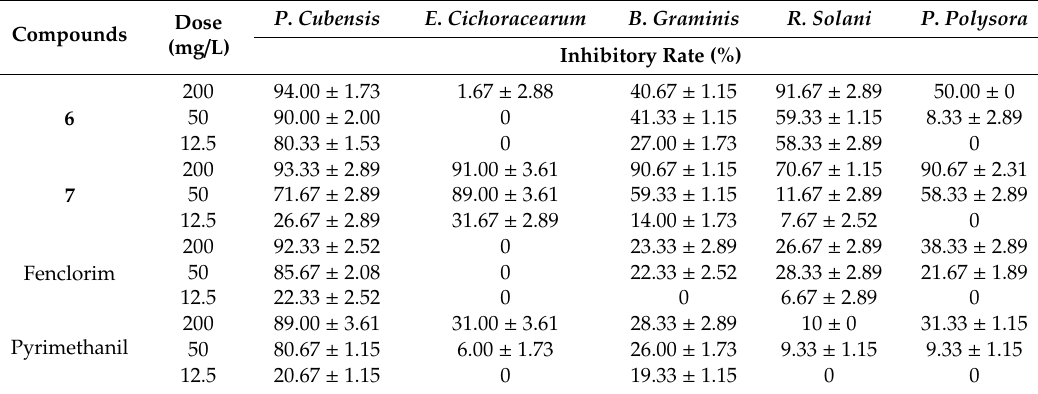
Table 7. The in vitro fungicidal activities of compounds 6 and 7